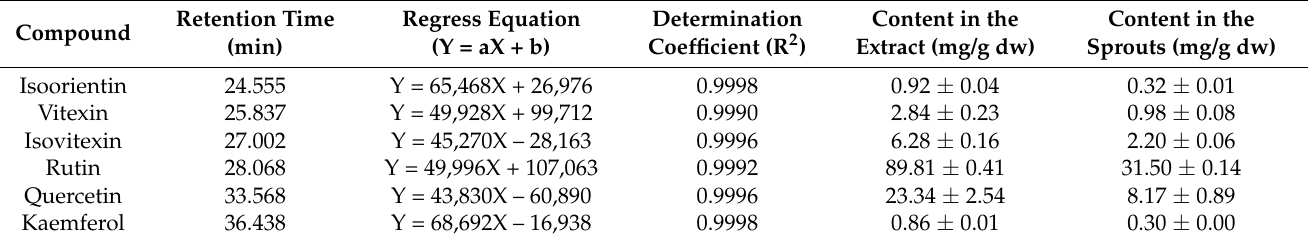
Table 1. The flavonoid content of the crude extract and sprout cultures of Tartary